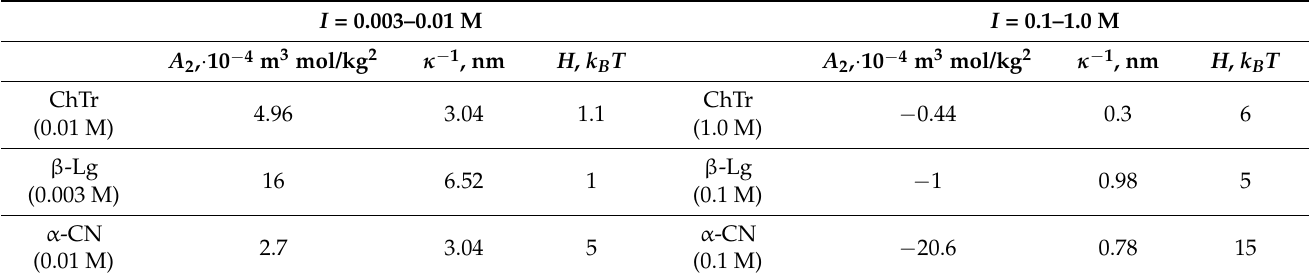
Table 2. Second virial coefficient A 2 , Debye screening length κ − 1 , Hamaker constant H of ChTr, β -Lg, and α -CN at various ionic strength I values [73,79,106,128].